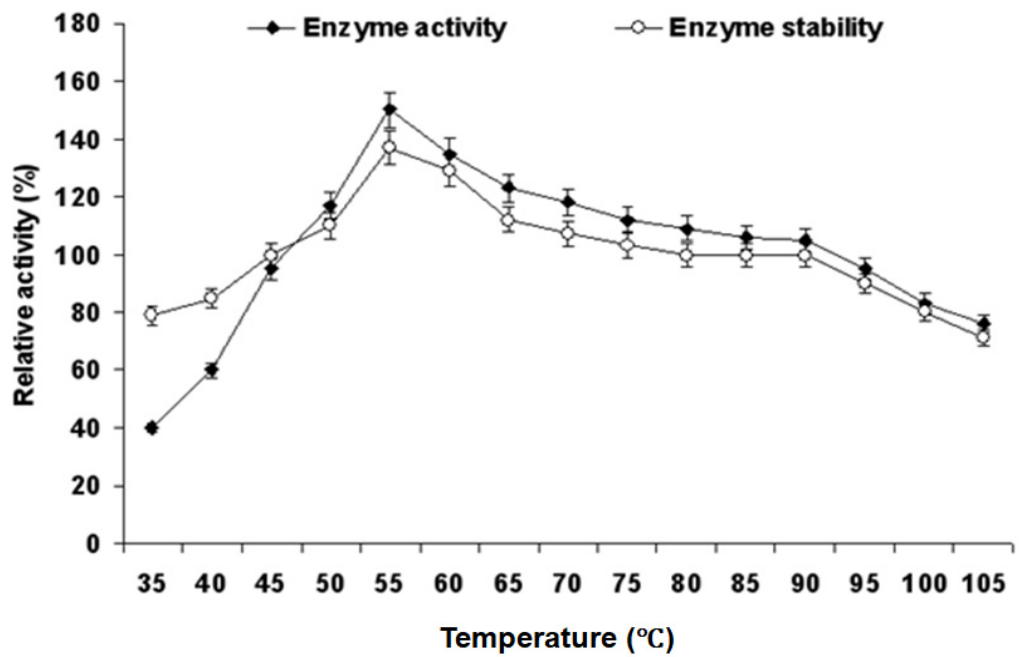
Figure 3. Effect of temperature on enzyme activity and stability. The reaction mixture was incubated at various temperatures (35–105 °C) for enzyme activity. For enzyme stability, the enzyme was pre-incubated at respective temperatures for 1 h, and the reaction was carried out as per the standard test method.